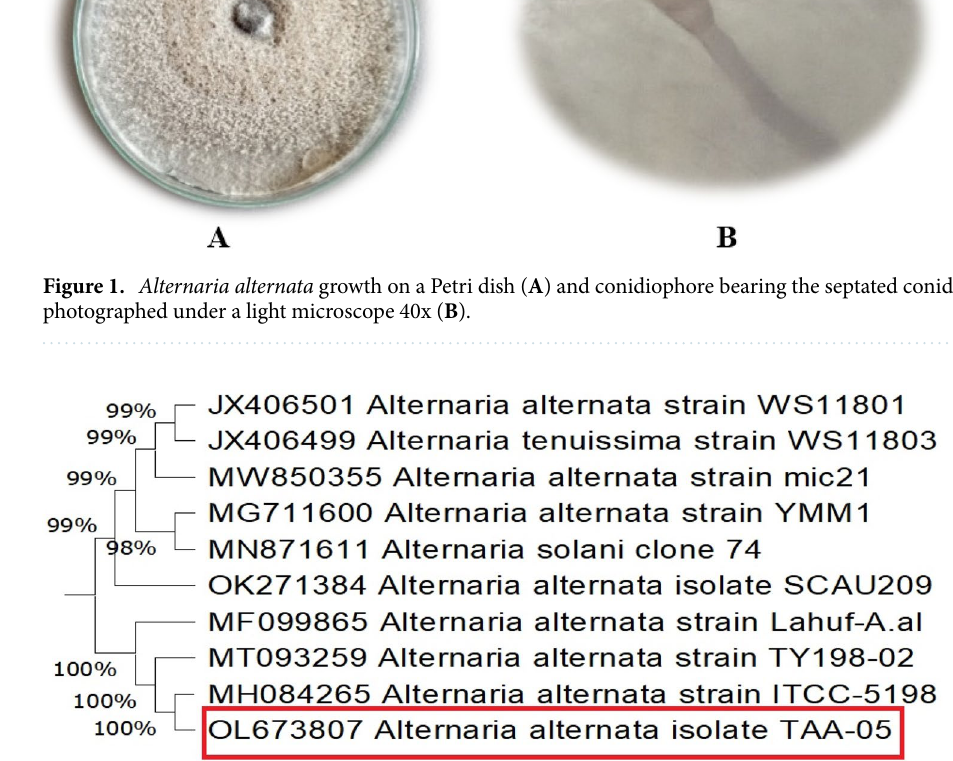
Figure 2. Constructed phylogenetic tree based on 10 most parsimonious ITS sequences. The Egyptian fungal isolate is Alternaria alternata TAA-05